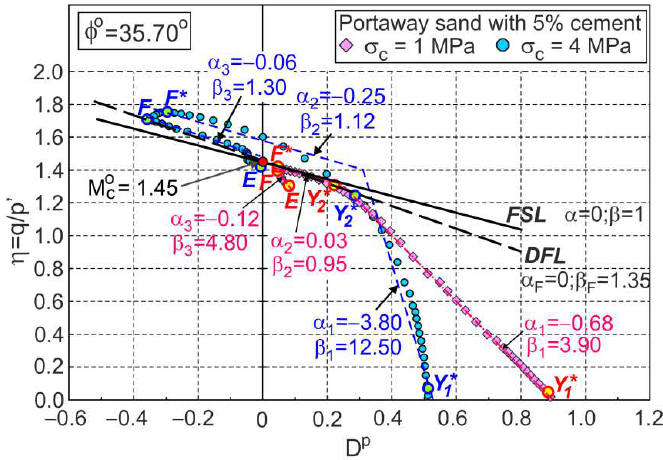
Figure 4. Linear approximations of stress–plastic dilatancy relationships for drained triaxial compression tests of Portaway sand with 5% cement.